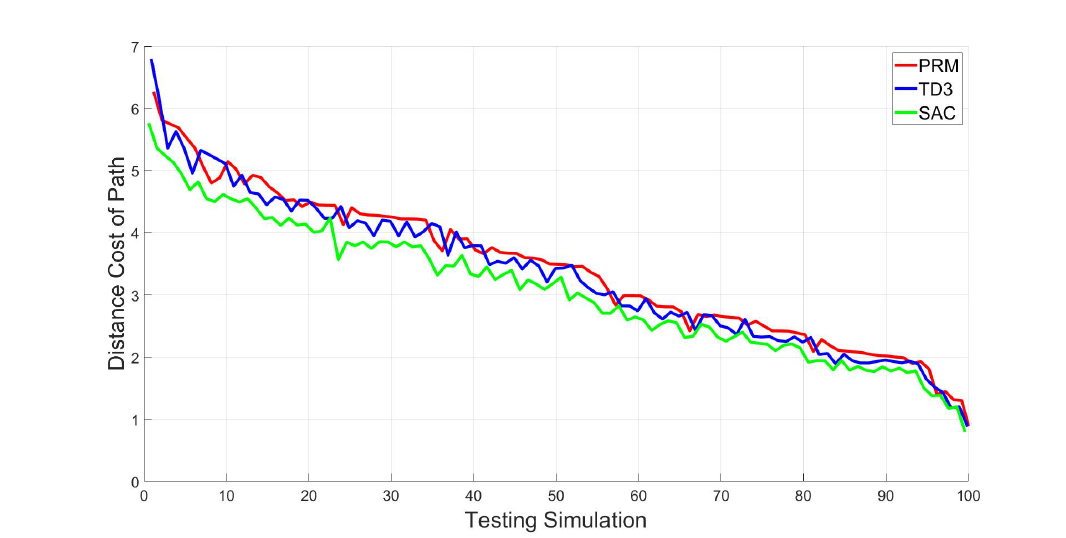
Figure 12. Comparison of paths by PRM, TD3 with HER and the proposed method.